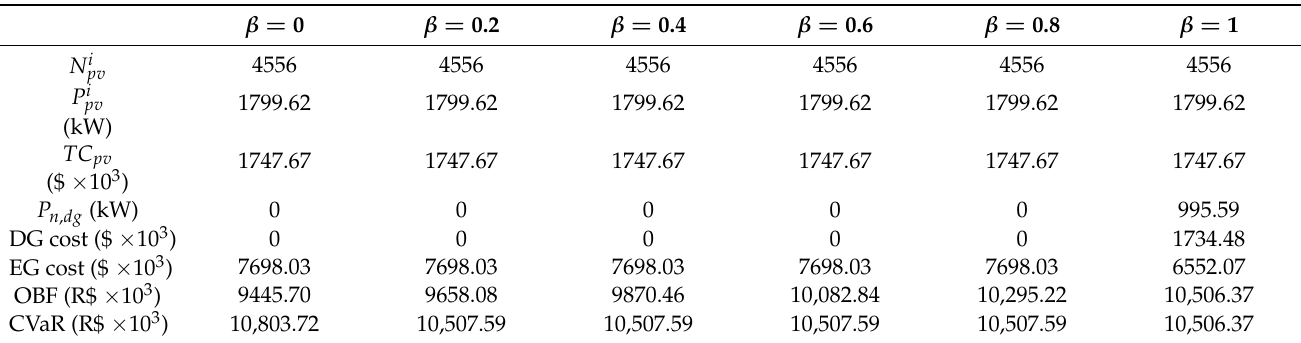
Table 12. Results for the hydrological adverse conditions.